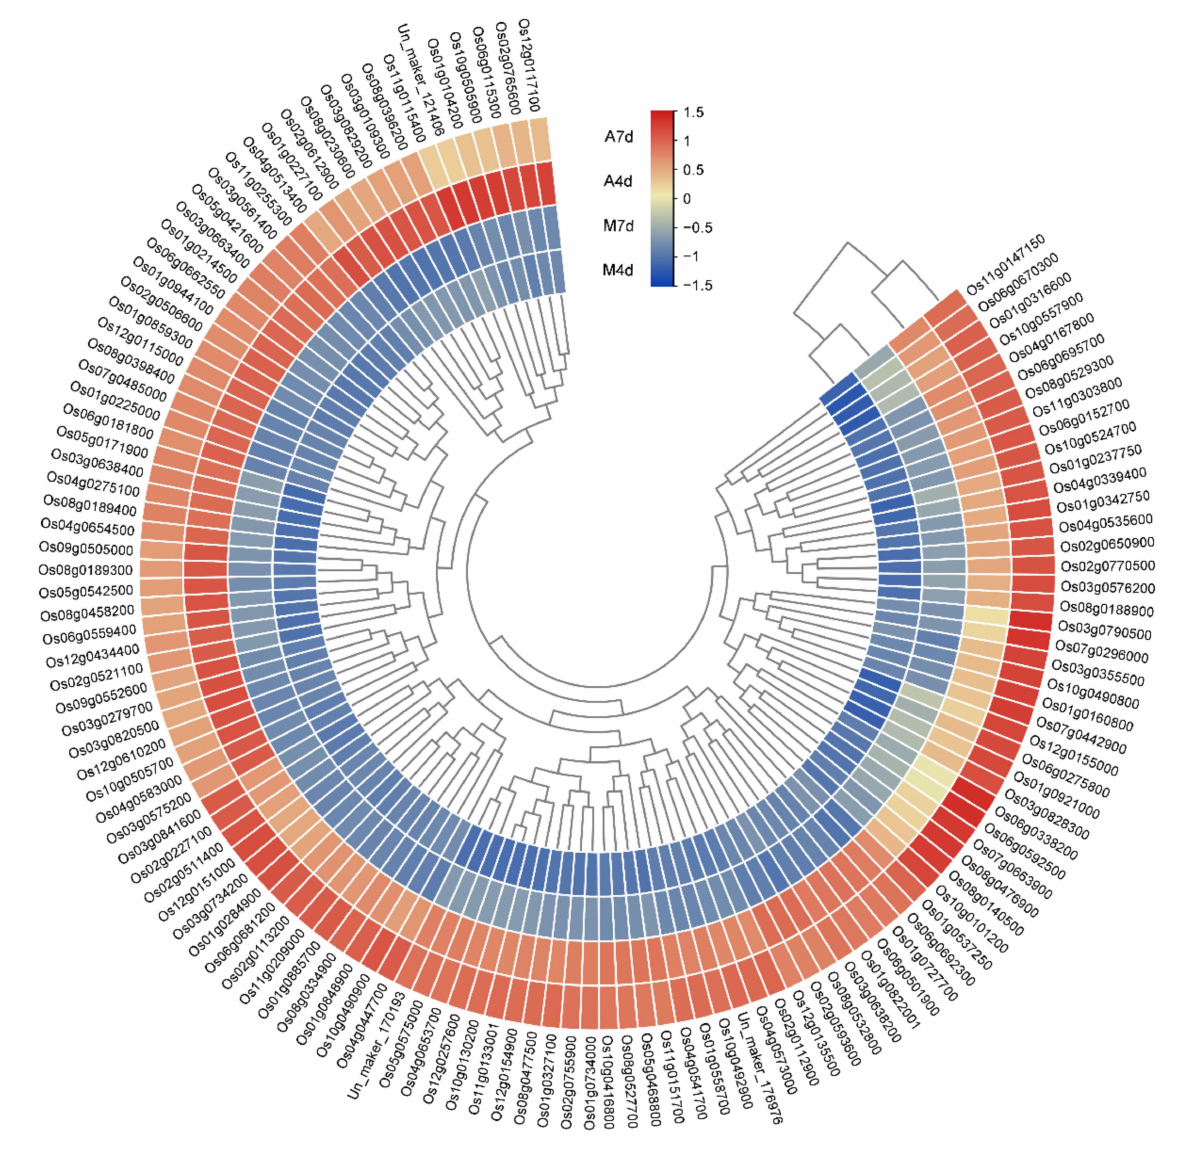
Figure 7. Identification of 125 genes was unique induced by alkaline stress in M4d, M7d, A4d and A7d.